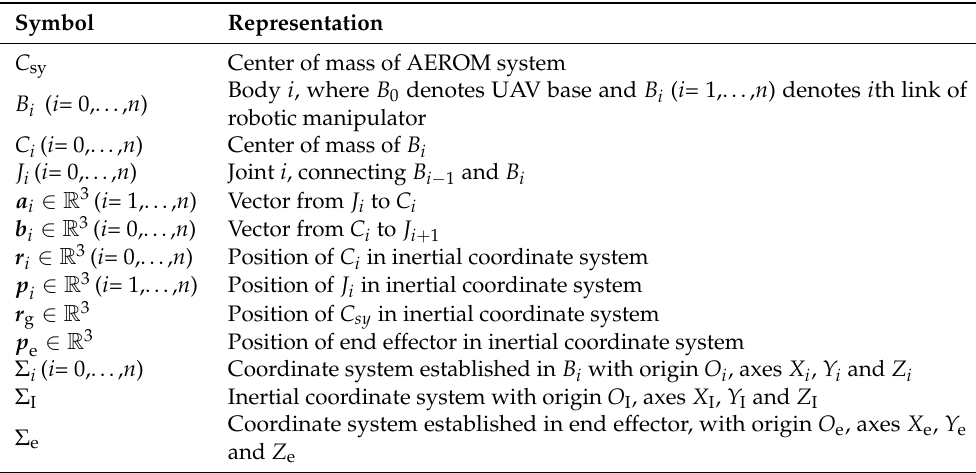
Table 1. Representation of symbols in Figure